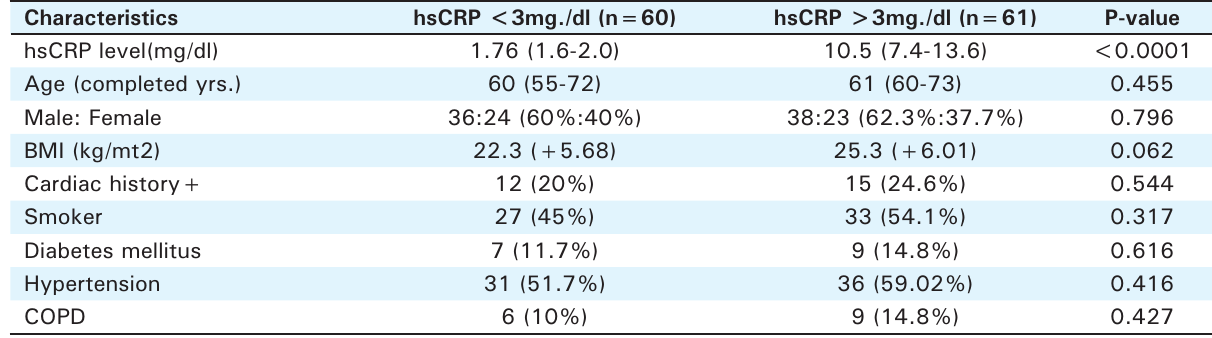
Table 1. Preoperative characteristics of subjects grouped according to hsCRP level < or >3mg/dl